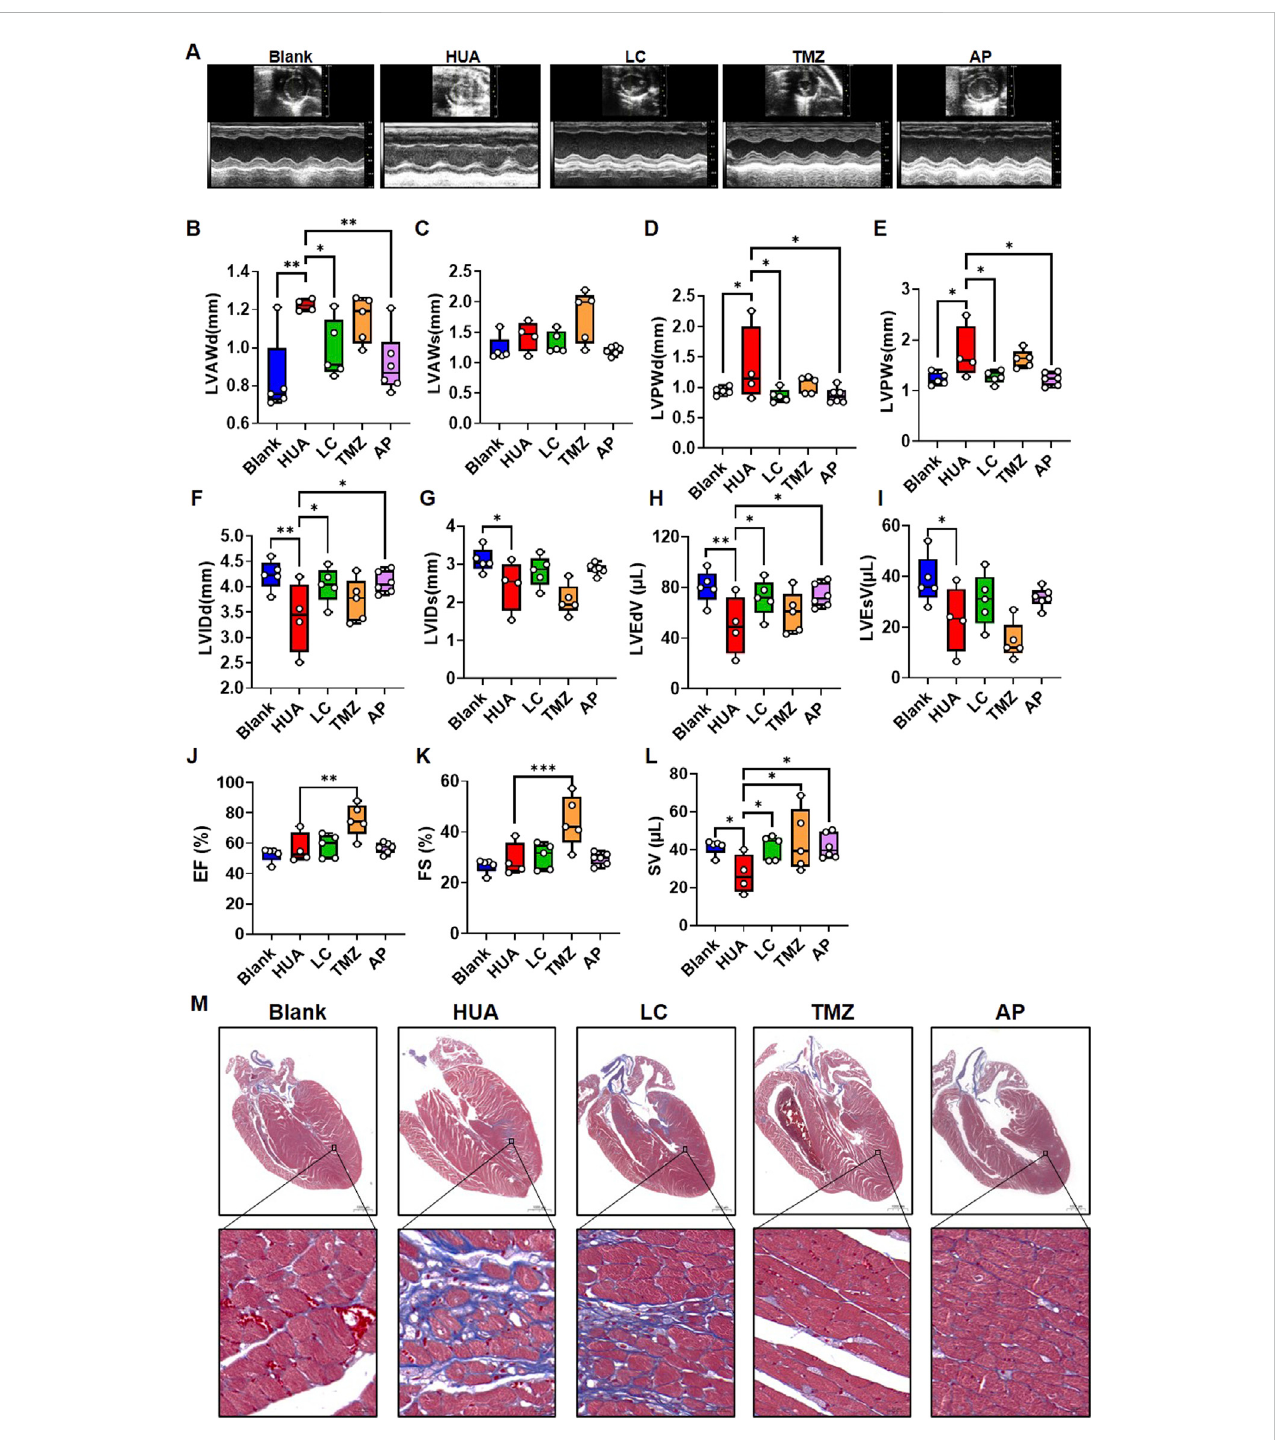
FIGURE 6 The in fl uence of fatty acid metabolic agents ’ intervention on the cardiac function of chronic HUA mice. (A) Representative photo of echocardiography examination in each group. Echocardiographic examination was performed after 8 weeks experiment. The summarized box plot of left ventricular anterior wall in diastolic-stage (B) , left ventricular anterior wall in systolic-stage (C) , left ventricular posterior wall in diastolic-stage (D) , left ventricular posterior wall in systolic-stage (E) , left ventricular internal dimension in diastolic-stage (F) , left ventricular internal dimension in systolic-stage (G) , left ventricular end- diastolic volume (H) , left ventricular end-systolic volume (I) , ejection fraction (J) , fractional shortening (K) , stroke volume (L) . blank n = 5, HUA n = 4, LC n = 5, TMZ n =5,AP n =6; (M) Massonstaining oftheheartsamplesineachgroup after8-weeks ’ treatment.Red indicatesmuscle, blueindicates fi brous,scale bar= 1000 μ